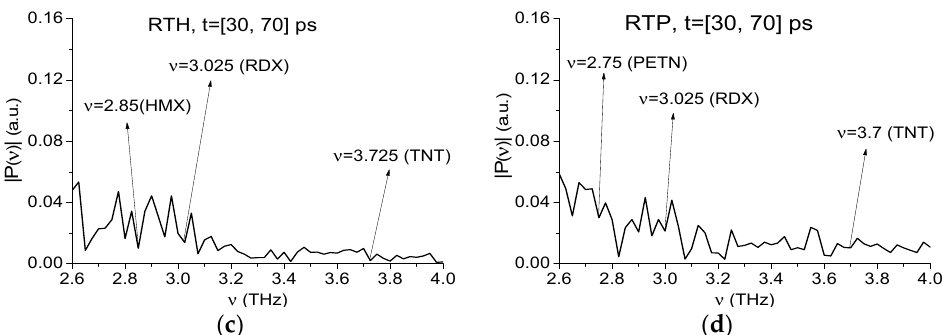
Figure 13. Spectra of the RTH ( a,c ) and RTP ( b,d ) signals computed in the time interval t = [30, 70] ps, in the frequency ranges ν = [0.6, 2.6] THz ( a,b ), and [2.6, 4.0] THz ( c,d ).